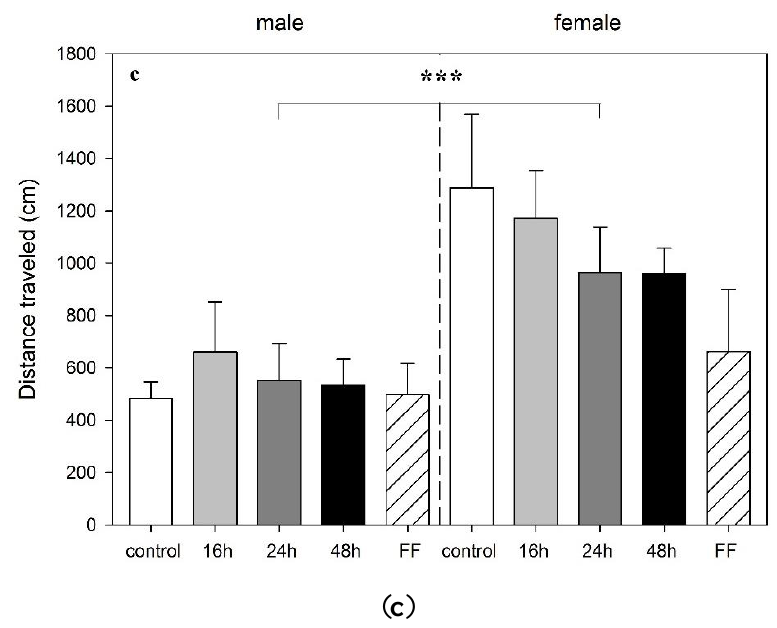
Figure 4. Effect of food deprivation (16 h, 24 h, 48 h), fixed-time feeding schedule (FF; 4 h for 4 days) or free-feeding (control) on the performance in the elevated plus maze test in male and female rats. ( a ) Percentage of open arm entries; ( b ) time in open arms; and ( c ) distance traveled are shown. Data is mean +S.E.M. Two-way ANOVA showed sex significance, (A and B: * p < 0.05; C: *** p < 0.001) but no food deprivation significance.